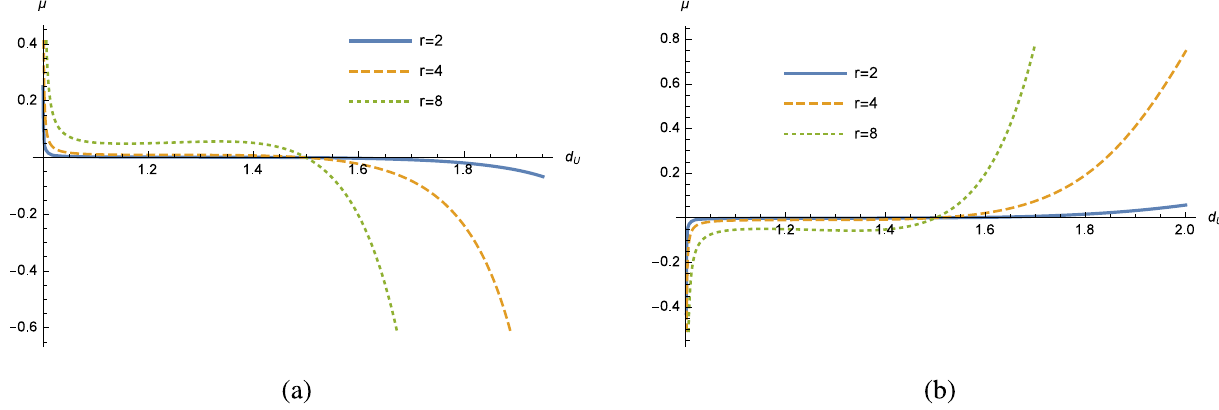
Fig. 2 Linear mass parameter μ as a function of d U for three values of r . In a we consider the scalar unparticle case, while in b we have the vectorial unparticle case. We have considered